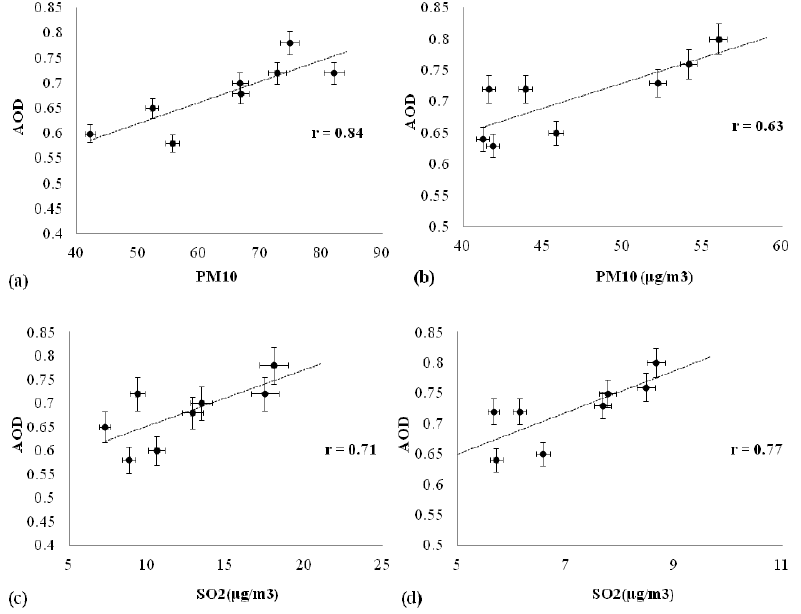
Figure 3. Scatter diagram of monthly PM10 and AOD over 8 years for ( a ) pre-monsoon (April–May) and ( b ) monsoon (June–September) and that of monthly SO2 and AOD for ( c ) pre-monsoon (April–May) and ( d ) monsoon (June–September). Crosshairs represent first standard deviation of the parameters.